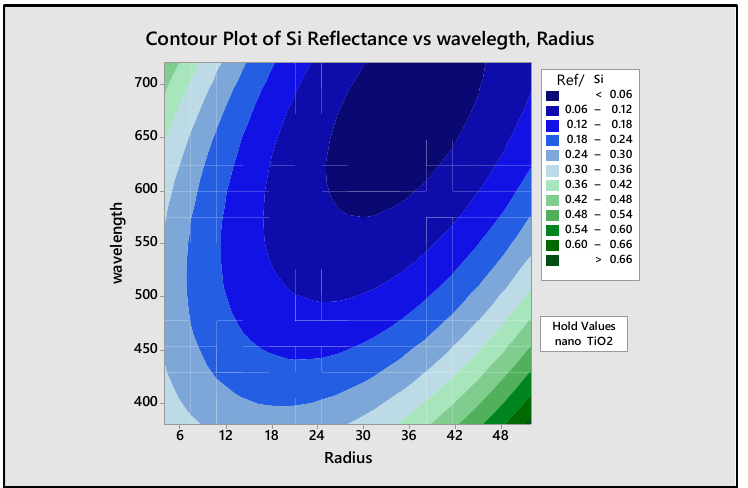
Figure 6. Contour plot of TiO 2 reflectance vs. wavelength and radius.